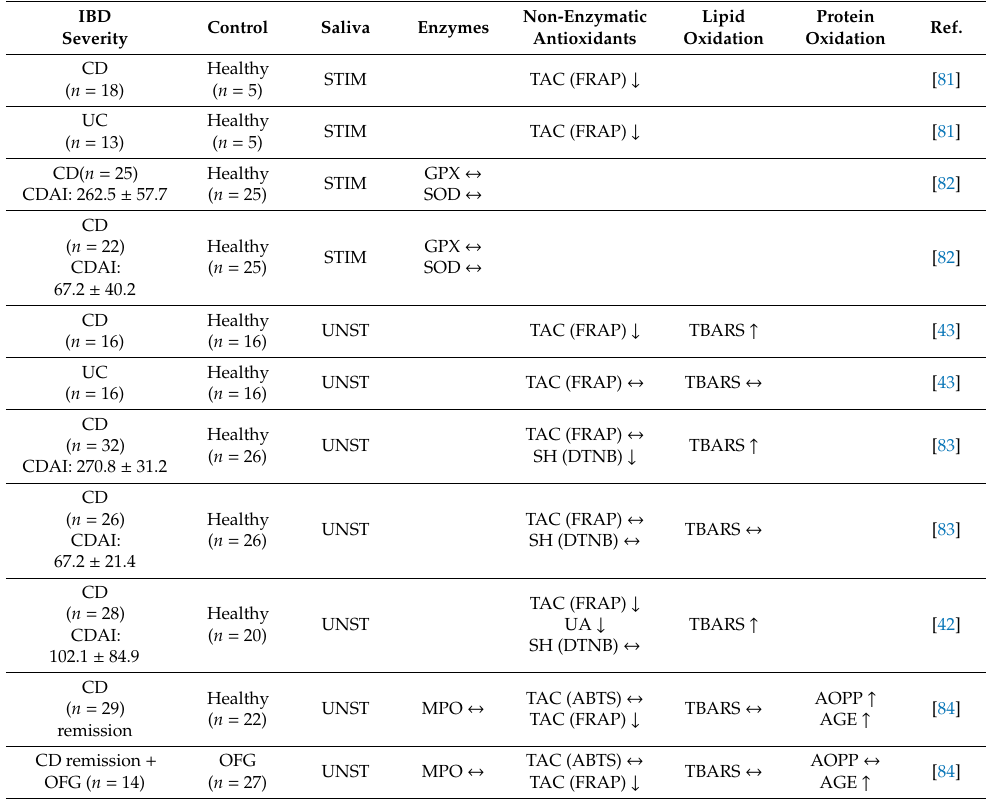
Table 2. Oxidative stress markers in case-control